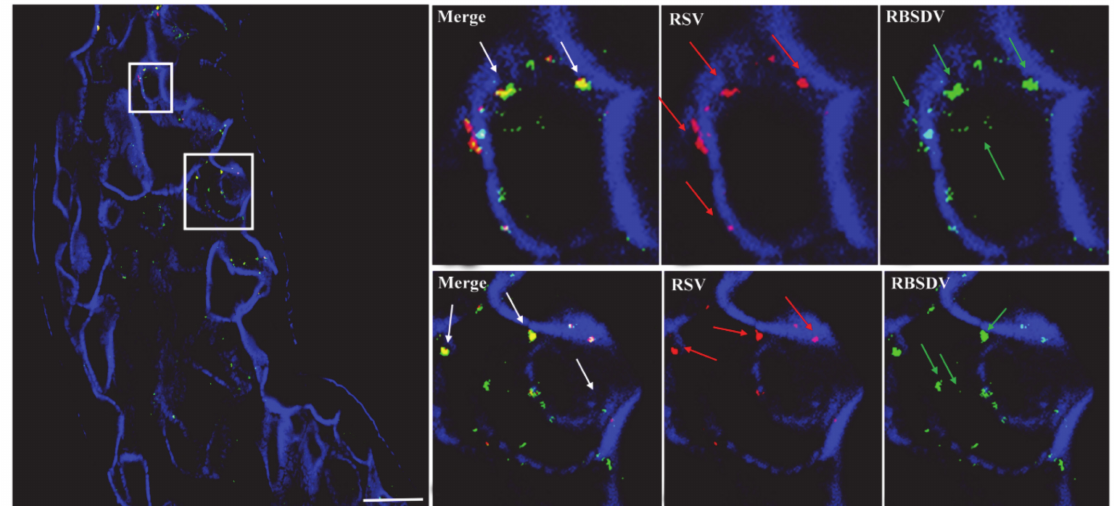
Figure 2. Localization of RBSDV and RSV in epithelial cells of midgut excised from third instar nymphs after RBSDV first–RSV second access. The image on the right are the amplification of the white squares. RSV was detected using Alexa Fluor 549 (red), RBSDV using Alexa Fluor 488 (green), and Alexa Fluor 633 phalloidin was used to label actin (blue). Scale bar, 20 µ